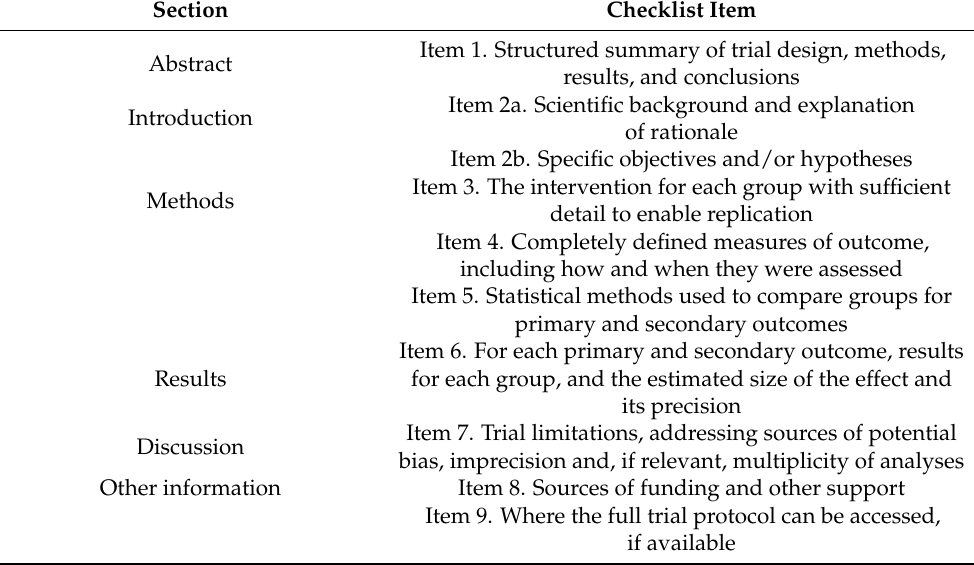
Table A1. Modified CONSORT checklist for in vitro studies comparing different dental implant impression